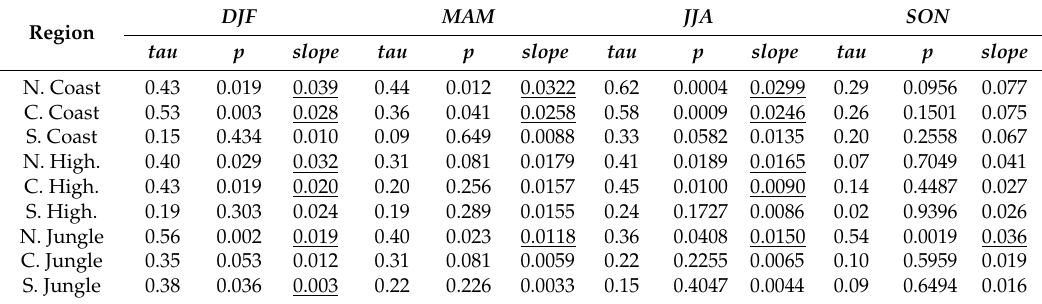
Table 6. Same as Table 5, for ERA-Interim data and the period 1979–2017. Negative slopes are colored in red.